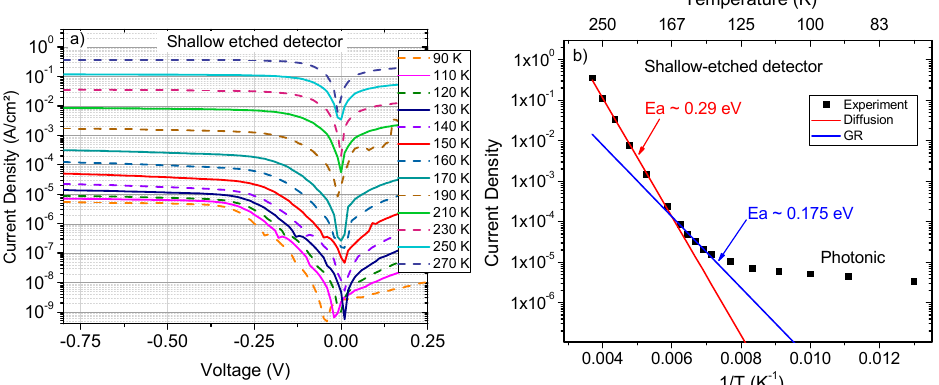
Figure 8. ( a ) Dark current density measured for a shallow-etched device with a 210 µm diameter at different temperatures; ( b ) temperature dependence of dark current density at − 0.4 V.